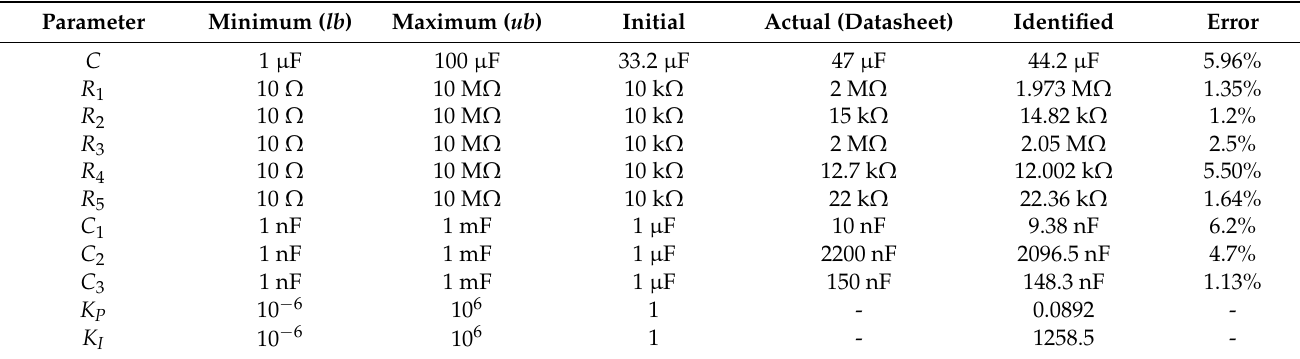
Table 5. Optimization conditions of the NLS identification algorithm of the control loop and comparison of actual and identified parameters.